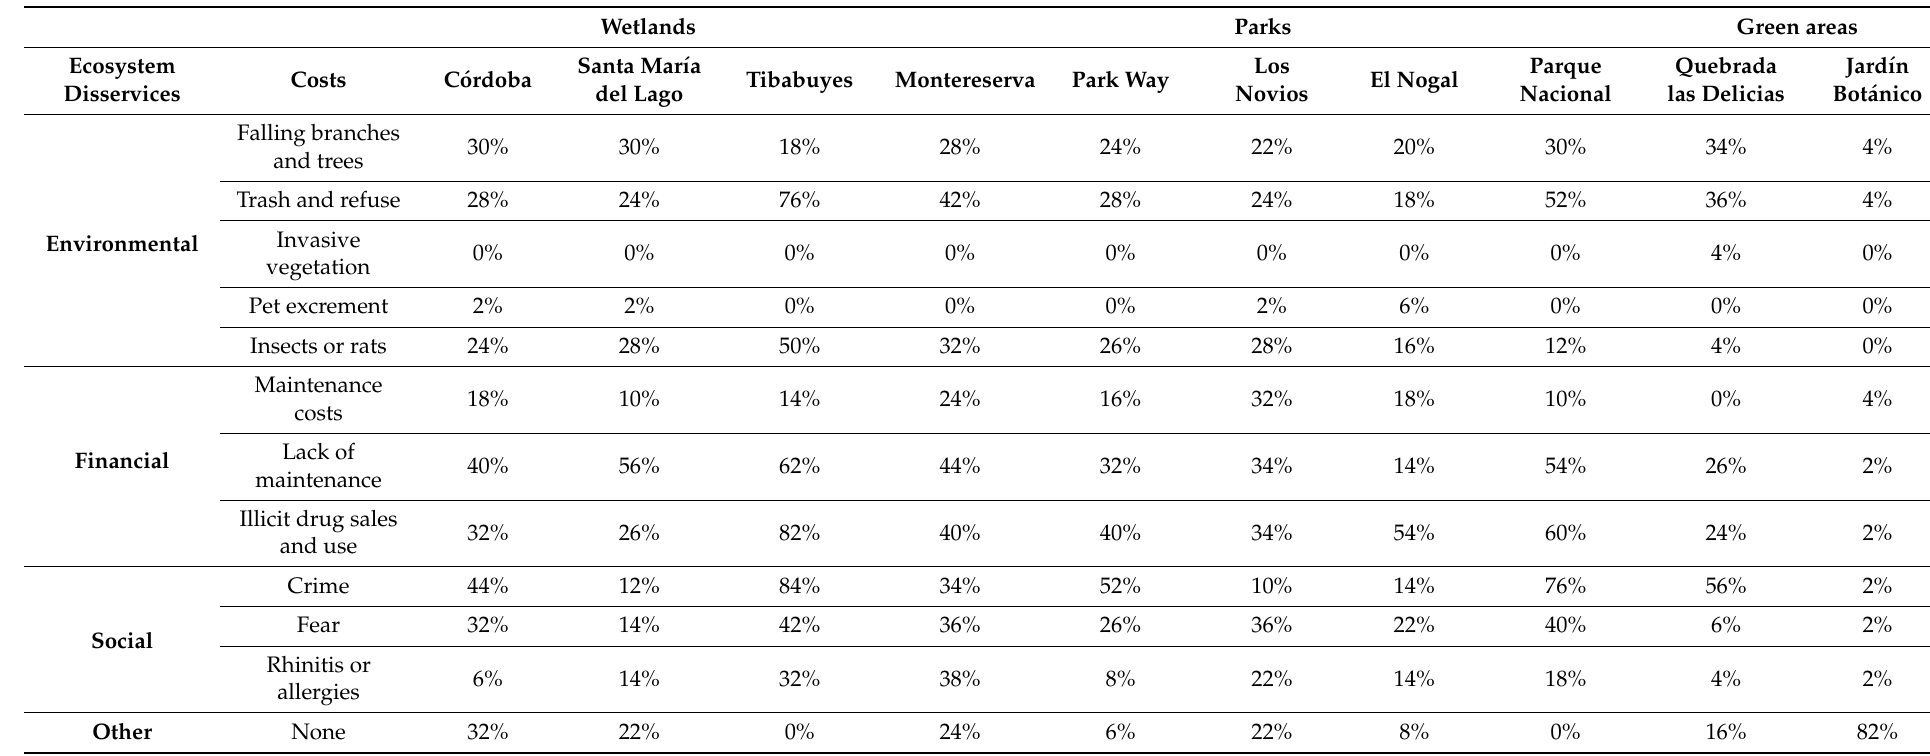
Table 4. Perception towards costs in 10 different green areas and wetlands in the El Salitre sub-watershed. Note: We integrate both the ecosystem disservices and problems from nature metaphors to better represent Bogota, Colombia’s context and what citizens least value from ecosystems and